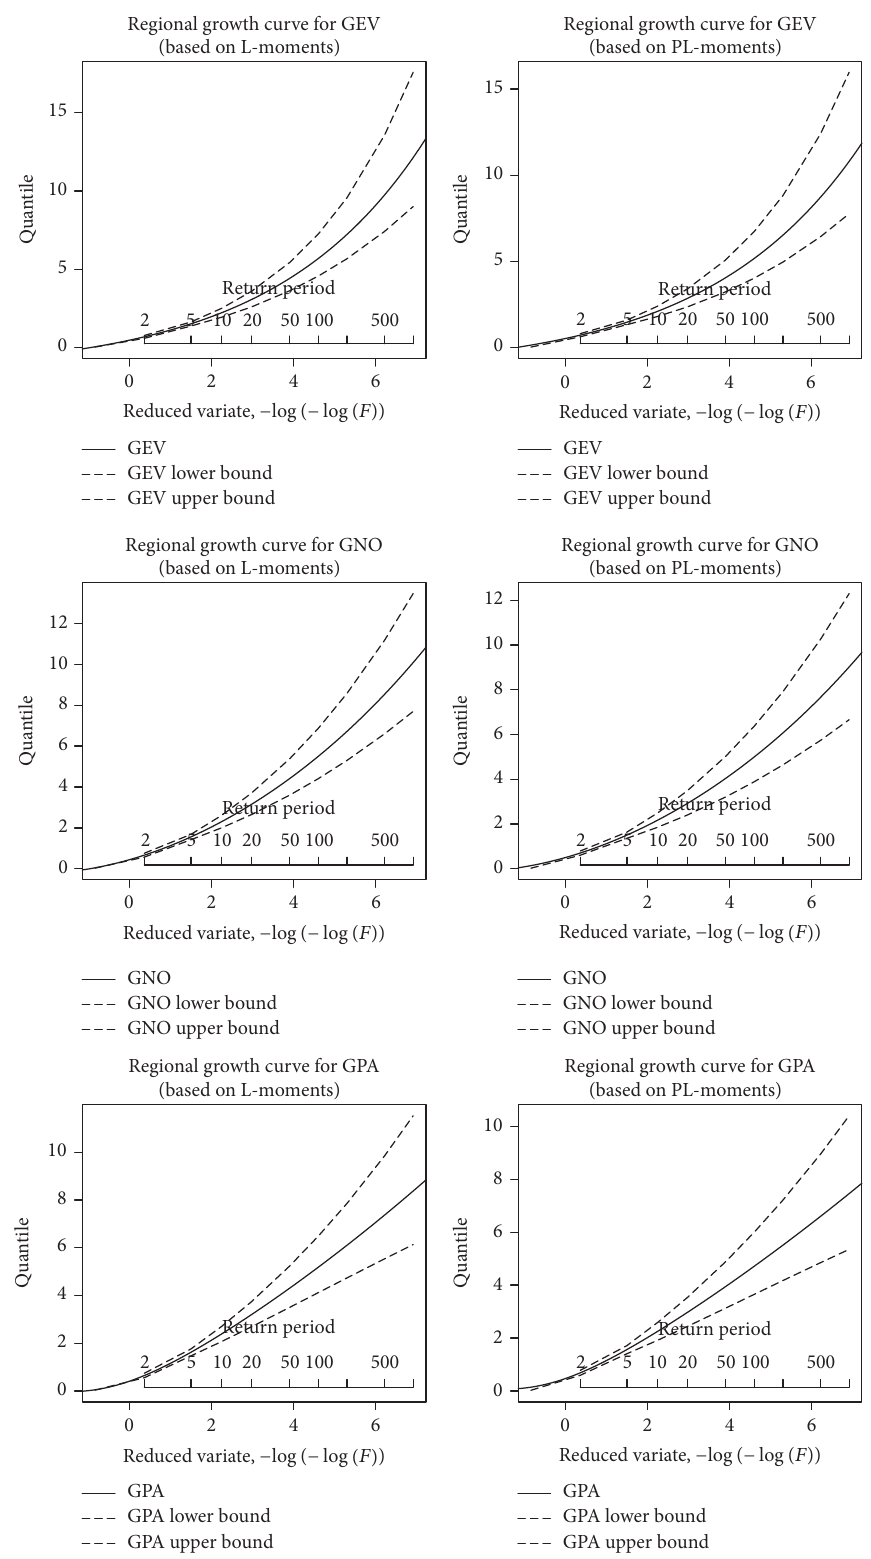
Figure 5: Regional growth curves of the three distributions for L-moments and PL-moments with their 90% error bounds for sample size of